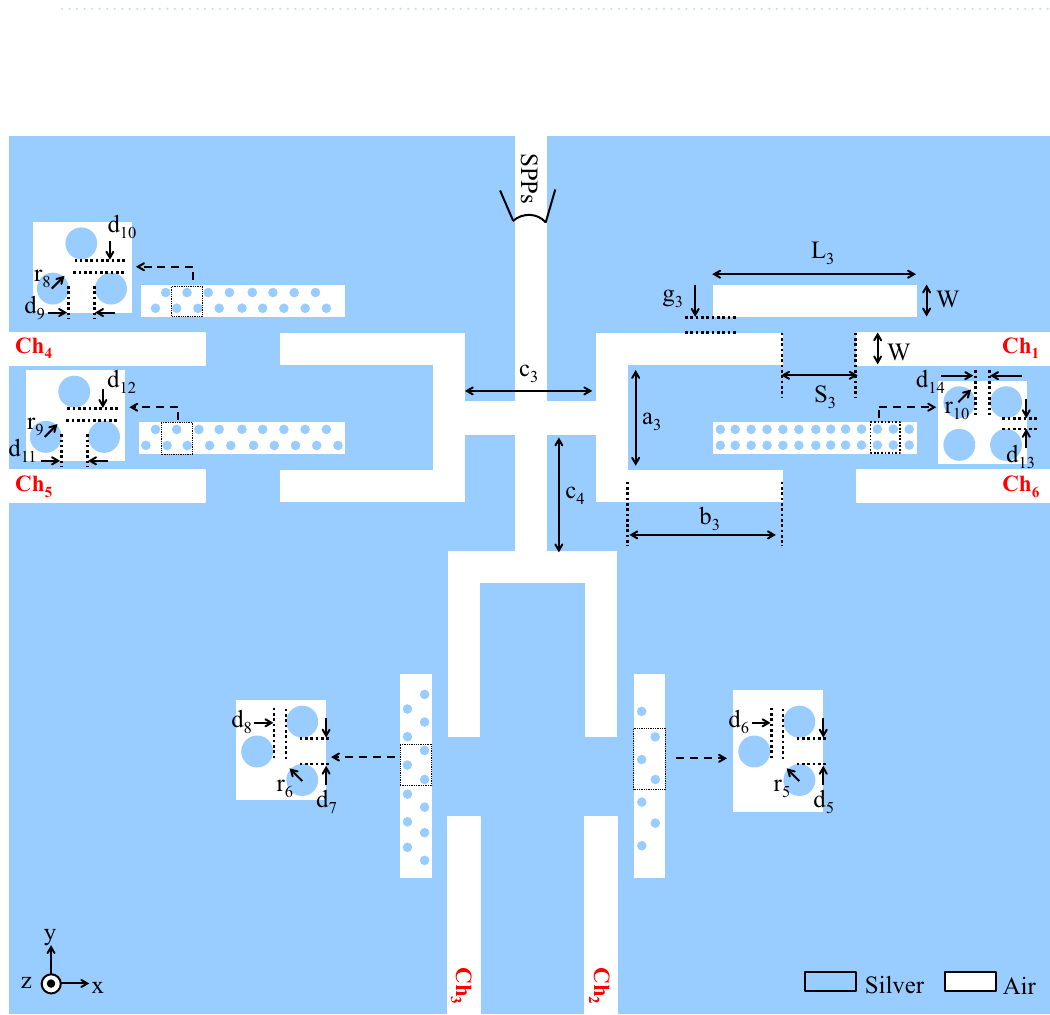
Figure 12. Schematic of the proposed six-channel